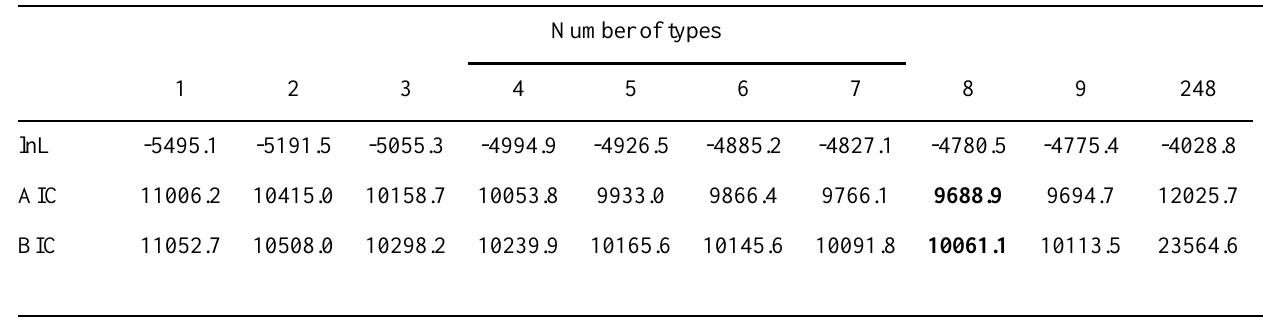
Table 5 . The value of maximum likelihood (InL), the Akaike Information Criterion (AIC), and the Bayesian Information Criterion (BIC) for different numbers of types distinguished by maximum likelihood estimation using the method of El-Gamal and Grether (1995) for 10-round